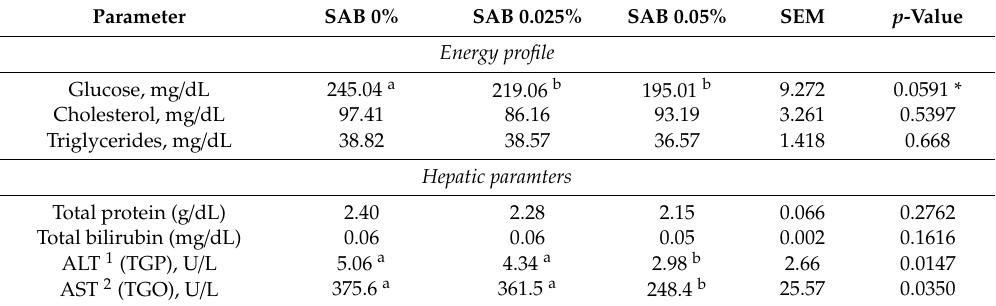
Table 3. E ff ect of dietary SAB powder on serum biochemical parameters (average values /